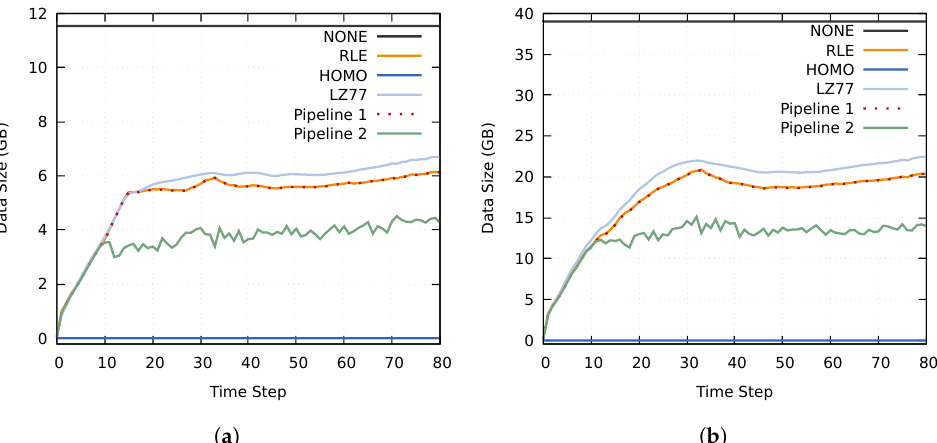
Figure 10. Size of the transferred compressed data using the MF, MY, and MZ data sets on ( a ) cluster A and ( b ) cluster B. The results of the RLE and Pipeline 1 tests